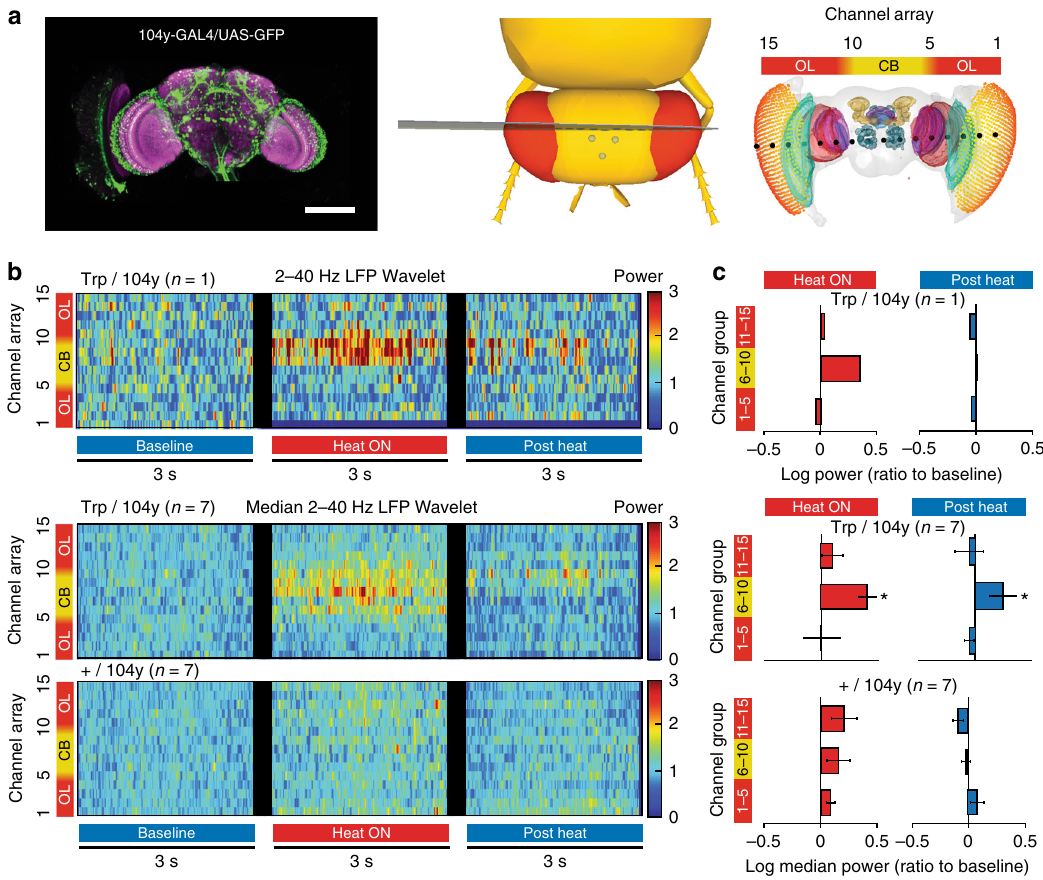
Fig. 2 Thermogenetic sleep induction increases 2 – 40 Hz power in the central brain. a Left image shows the expression pattern of 104y-Gal4 circuit as visualized by green fl uorescent protein (GFP) expression (green). The synaptic marker nc82 highlights neuropil structures (magenta). Middle and right panels indicate the approximate locations of the 16 channel probe (15 functional channels) in a standardized Drosophila brain 21 . The channels were grouped into three regions: two optic lobes region (left and right, OL), and the central brain (CB). Scale bar = 100 μ m. b Spectrograms show 2 – 40 Hz LFP power across all 15 channels (grouped as OL and CB) in 3-sec segments associated with heat conditions and then concatenated, for an individual fl y expressing 104y-Gal4/UAS-TrpA1 (Trp/104y, top), the combined median power for Trp/104y ( n = 7, middle), and 104y-Gal4/+ (+/104y, n = 7, bottom). Blue and red bars at the bottom indicate the temperature stimulus. c The 15 recording channels were grouped into the 3 aforementioned regions for the purpose of analysis. Bar plots shows the median 2 – 40 Hz LFP power during the periods of Heat ON (red) and Post Heat (blue) relative to values at baseline, which was normalized to zero. Comparisons were made for an individual UAS-TrpA1/104y-Gal4 fl y (top), the combined averaged power for UAS-TrpA1/104y-Gal4 (middle, n = 7, * p < 0.0125), and 104y-Gal4/+controls (bottom, n = 7, ns). UAS-TrpA1/+ controls were also tested (not shown) and no signi fi cant effects of heating were found ( n = 7). Statistical signi fi cance was determined by multi-factor ANOVA with post hoc contrasts on a three-way interaction term between brain regions, fl y line, and heat condition (Supplementary Note 1 and Supplementary Tables 1 and 2). Sample sizes indicate the number of fl ies tested. Images: Angelique